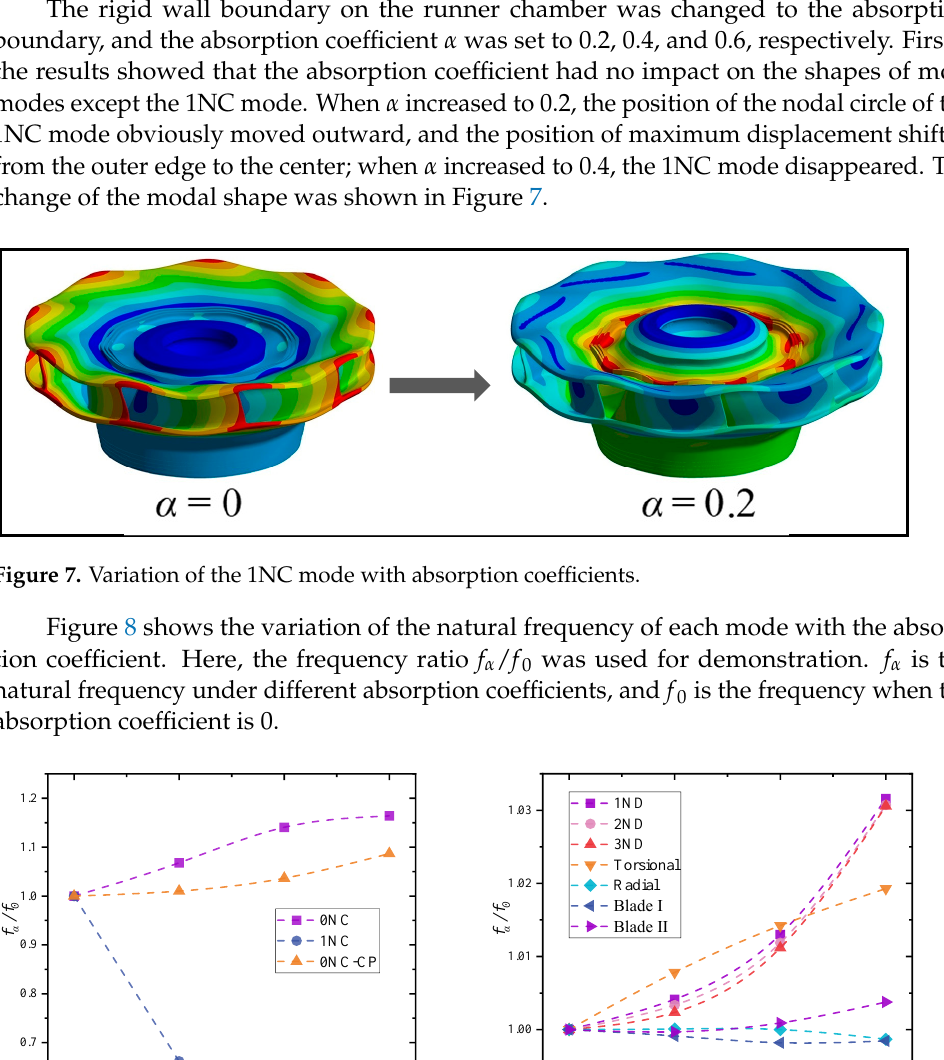
Figure 8. Variation of the natural frequencies with absorption boundary: ( a ) NC modes; ( b ) other modes. The results showed that, with the increase in the absorption coefficient on the runner chamber, the natural frequencies of the runner increased except for a few modes. It is well known that the proximity of the outer wall increases the added mass of water, thereby reducing the natural frequencies of the underwater structure. When the outer wall was not rigid, it vibrated along with the structure–water system and absorbed some of the energy in the pressure wave. At this time, the influence of the wall on the added mass was weakened, so the natural frequencies of the structure increased. Among them, the fre- quency change of the NC modes was the most significant, followed by the ND modes and the Torsional mode. The variation of the Radial mode and the blade vibration modes could be ignored. Compared with other modes, the frequencies of the NC modes changed too much; thus, they are shown separately in Figure 8a. For the NC modes, the change rule of the frequency of each mode was different. In particular, the frequency of the 1NC mode was abnormal. When α increased to 0.2, the frequency of the 1NC mode decreased by approximately 35%. Meanwhile, the frequencies of 0NC and 0NC-CP modes increased by 7% and 1%, respectively. For the ND modes, the change of the frequency of each mode with the absorption coefficient was almost the same. Additionally, with the increase in α , the frequency gradient of the ND modes increased. In fact, the proximity of the wall has very different effects on the added mass of dif- ferent modes. For example, during the movement of the nodal circle modes, the runner moves upward or downward as a whole to squeeze the water in the side chamber. At this time, the wall has a strong reaction force against the runner–water system, which causes a great added mass. For the blade vibration modes, the Radial mode, etc., the influence of the wall on the added mass is very small. The above results can be found in the study of Li et al. [21]. In the same way, when the absorption coefficient on the wall increased, the change in the added mass of the nodal circle modes was the most obvious, and the change in the blade vibration modes and the Radial mode was small. As for the abnormal change